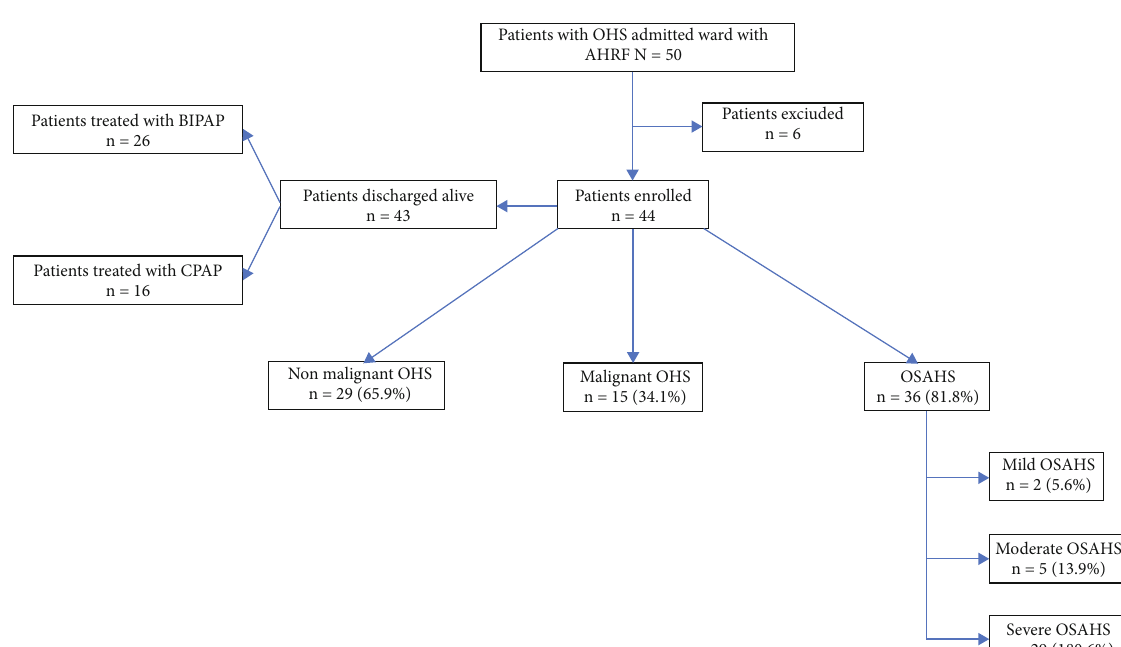
Figure 1: Composition of the study. OHS: obesity hypoventilation syndrome; OAHS: obstructive apnea-hypopnea syndrome; AHRF: acute hypercapnic respiratory failure; BIPAP: bilevel positive airway pressure; CPAP: continuous positive airway pressure; OSAHS: obstructive sleep apnea-hypopnea